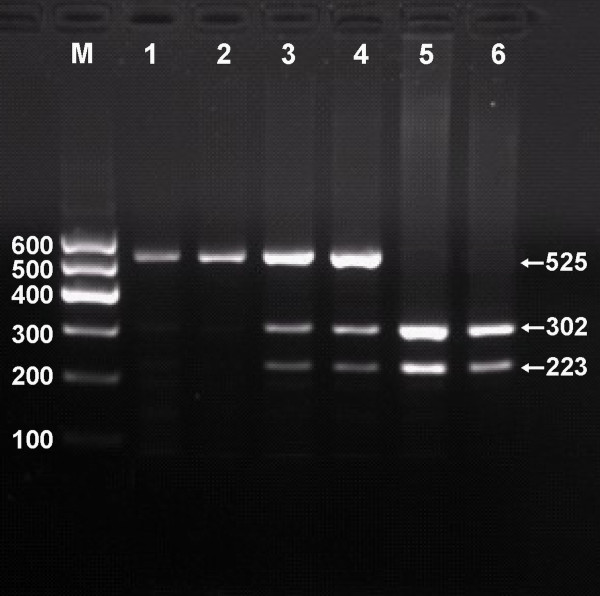
Genotyping of V825I polymorphism in the ABCA1 gene. Lane M, 100 bp marker ladder; lanes 1 and 2, GG genotype (525 bp); lanes 3 and 4, GA genotype (525-, 323- and 202-bp); and lanes 5 and 6, AA genotype (323- and 202-bp).